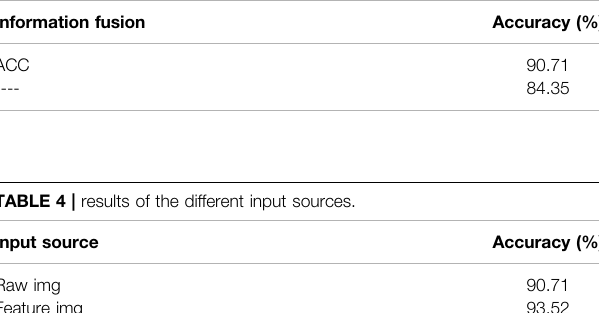
TABLE 2 | results of different networks. TABLE 3 | results of information fusion.